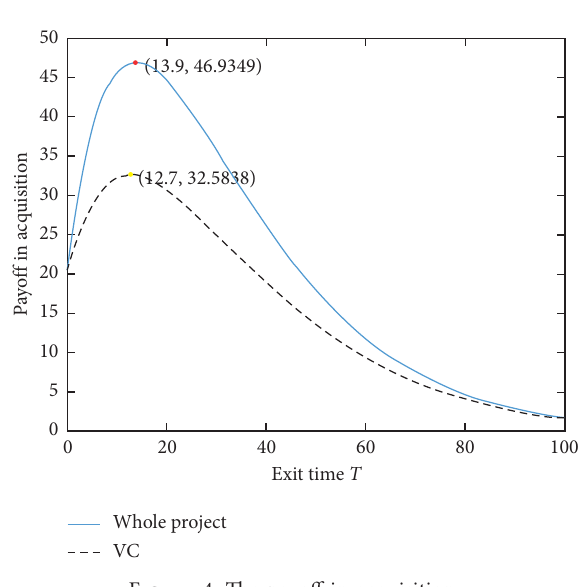
Figure 5: The optimal exit